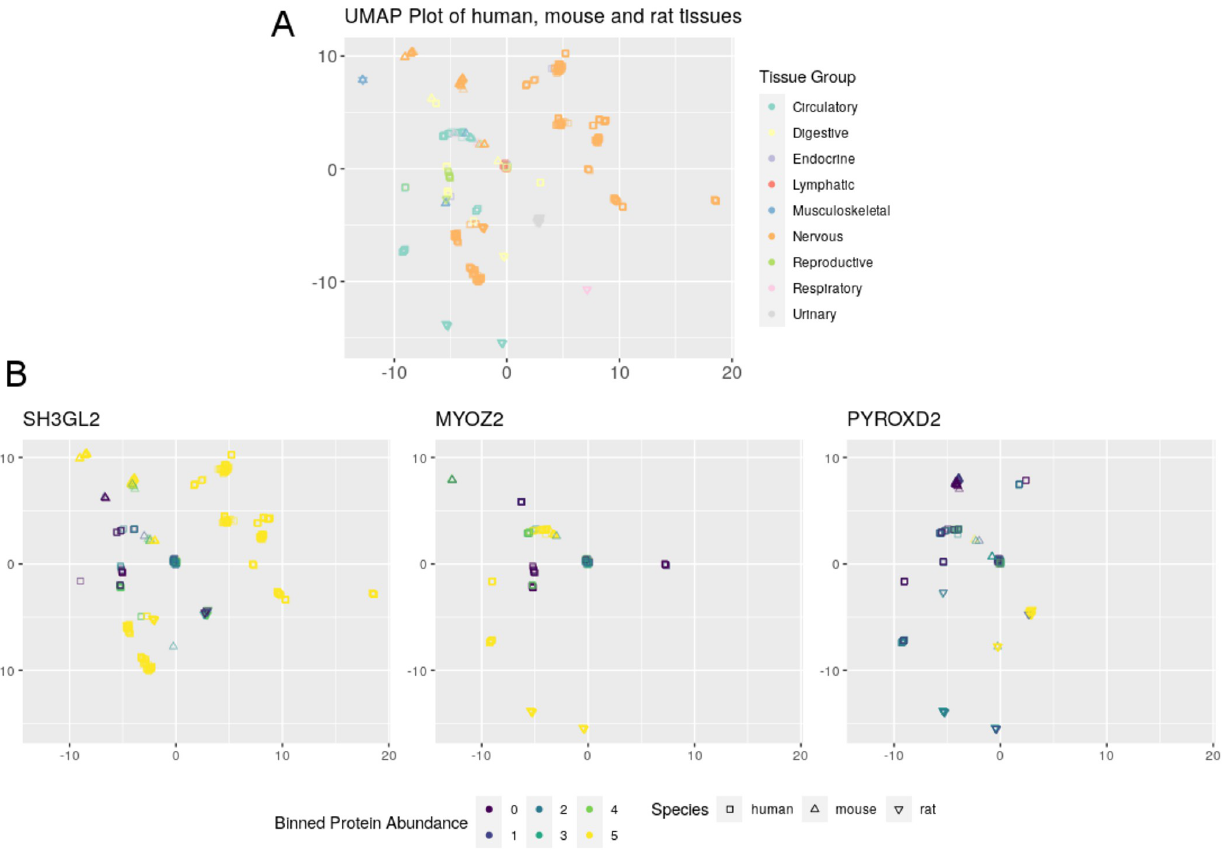
Fig 8. Visualisations generated using the UMAP algorithm to show the relationships between human, mouse, and rat samples. ( A ) Shows the relationship of all samples, particularly showing strong relationship between biological systems. (B ) Shows the protein abundancy of 3 example gene orthologs (SH3GL2, MYOZ2 and PYROXD2), within each sample. Human baseline protein expression data was generated in [14].